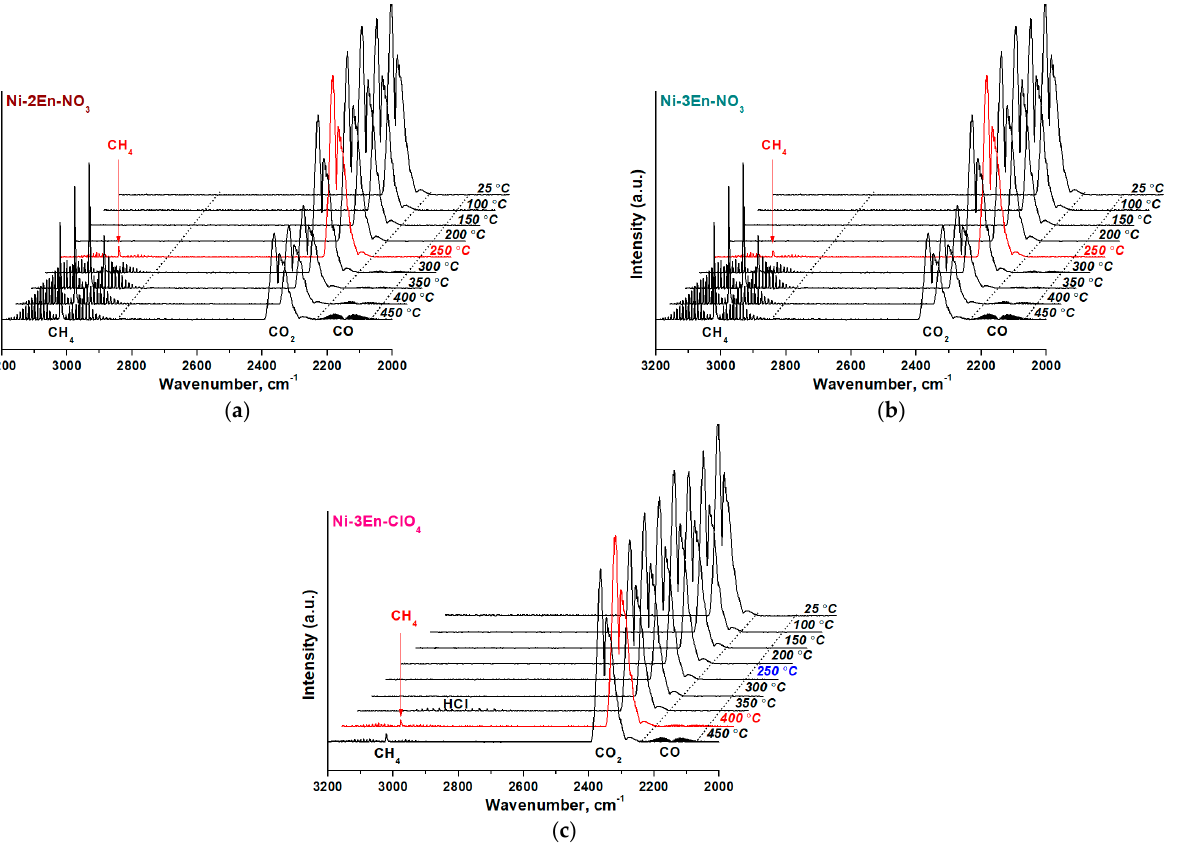
Figure 7. FTIR spectra of the gas mixture at the reactor outlet during the ( a ) Ni-2En-NO 3 , ( b ) Ni-3En-NO 3 and ( c ) Ni-3En-ClO 4 catalysts’ activation at different temperatures.